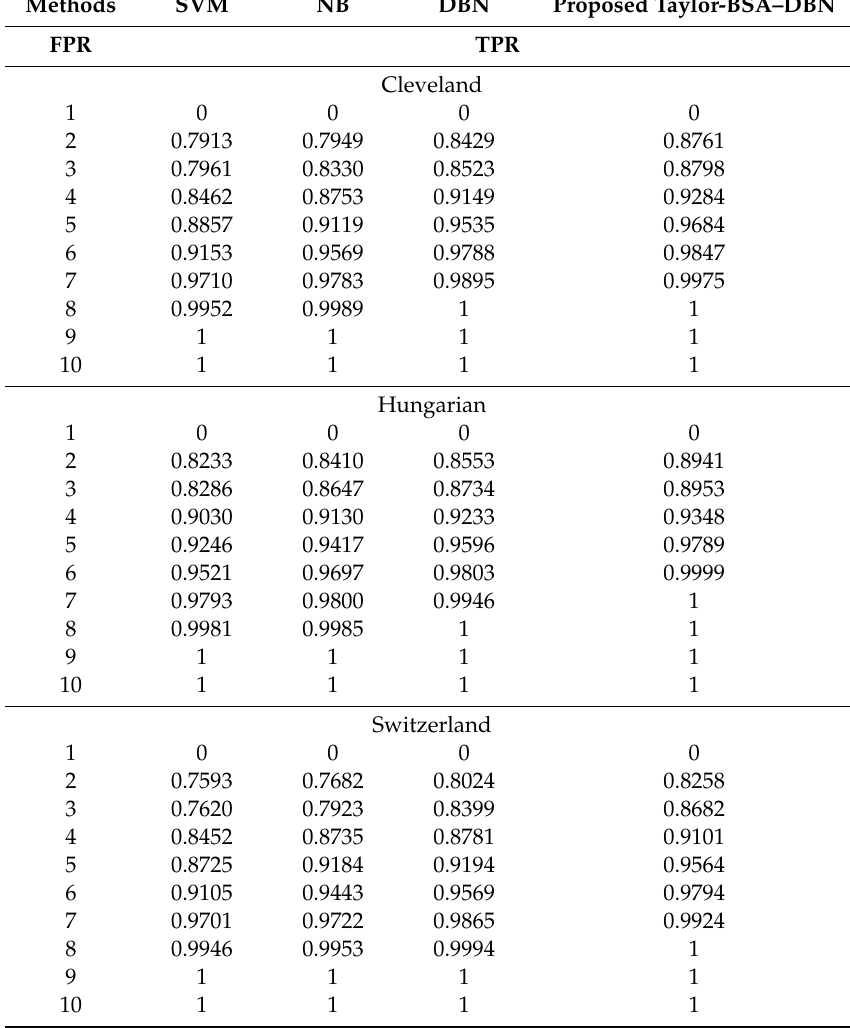
Table 8. Analysis based on